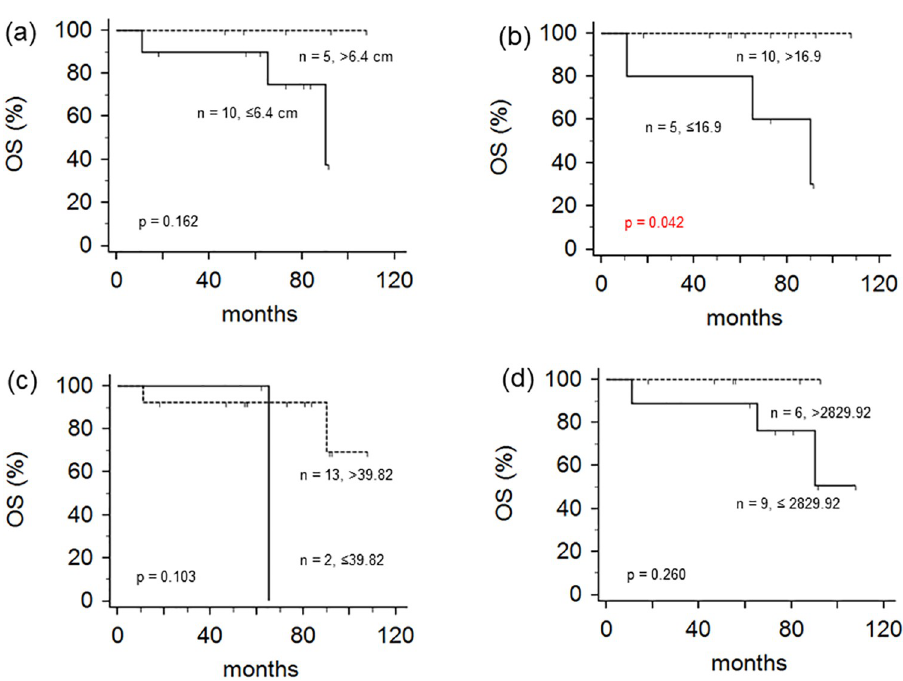
Fig 3. Kaplan-Meier survival curves depicting overall survival (OS) according to tumor size (a), the maximum standardized uptake value (SUVmax) (b), metabolic tumor volume (MTV) (c), and total lesion glycolysis (TLG)